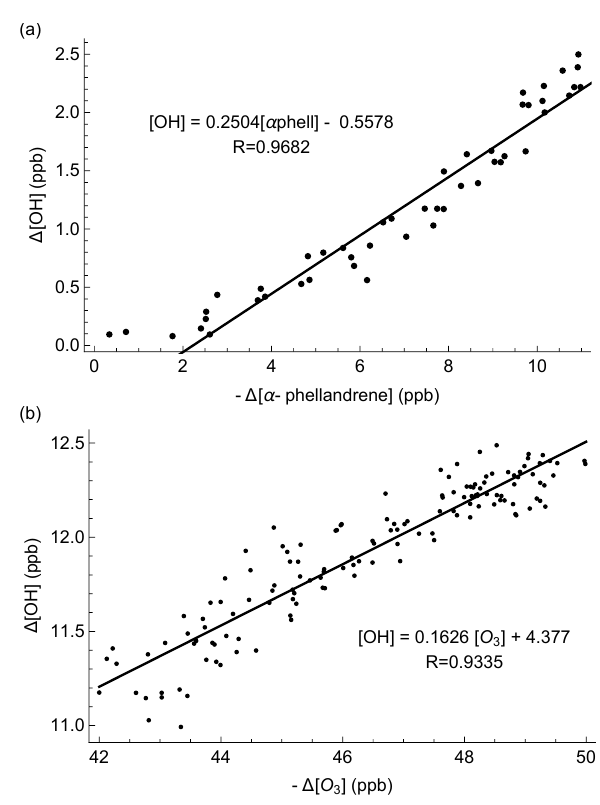
Figure 7. OH production from the (a) first and (b) second addition of ozone to α -phellandrene in experiment 3 against α -phellandrene and ozone consumption,